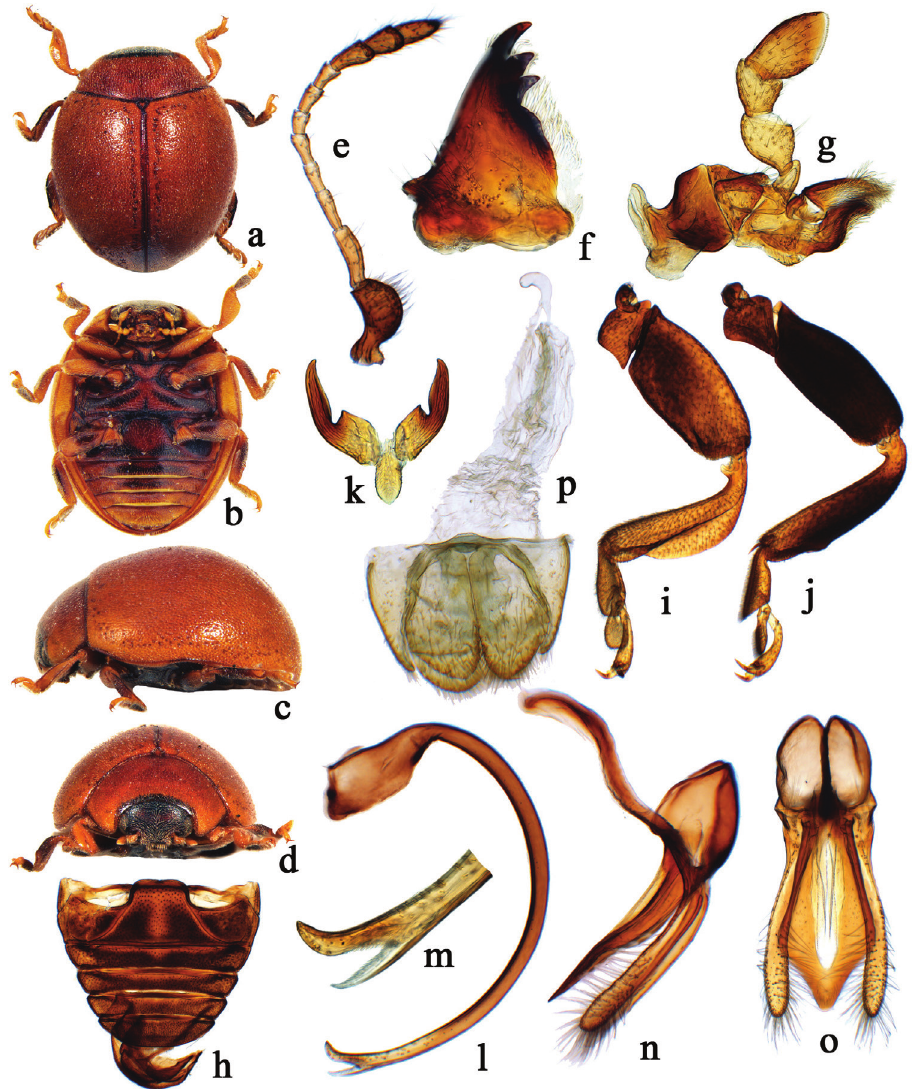
Figure 1. Morphological characters of the genus Cynegetis . a–o Cynegetis impunctata Linnaeus, 1767 From Poland. a dorsal habitus b ventral habitus c lateral habitus d frontal habitus e antenna f mandible g maxilla h abdomen i front leg j hind leg k tarsal claw l–o male genitalia: l penis m apex of penis n tegmen, lateral view o tegmen, ventral view p female genitalia: coxites and